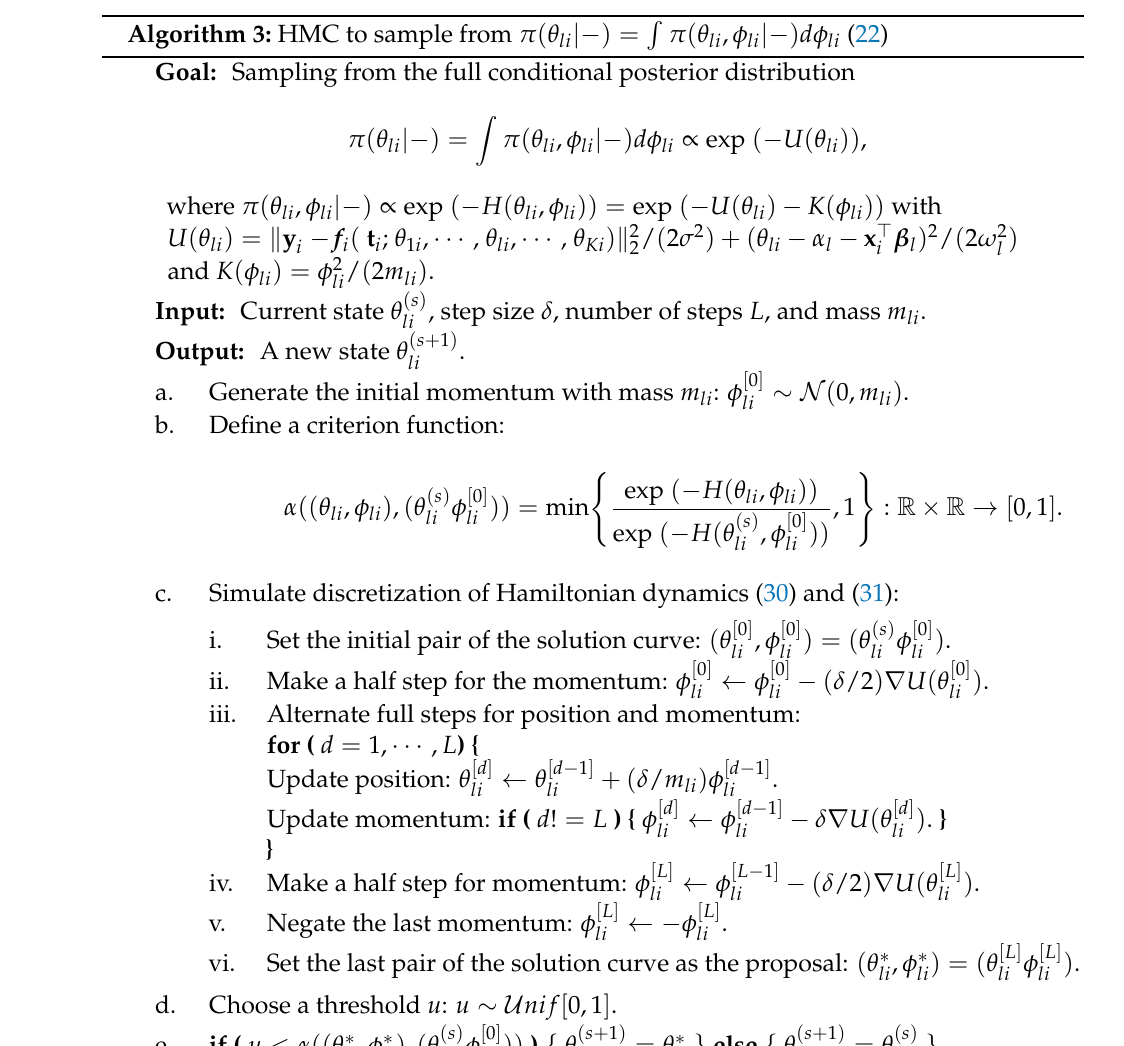
(cid:82) π ( θ li , φ li |− ) d φ li (22)